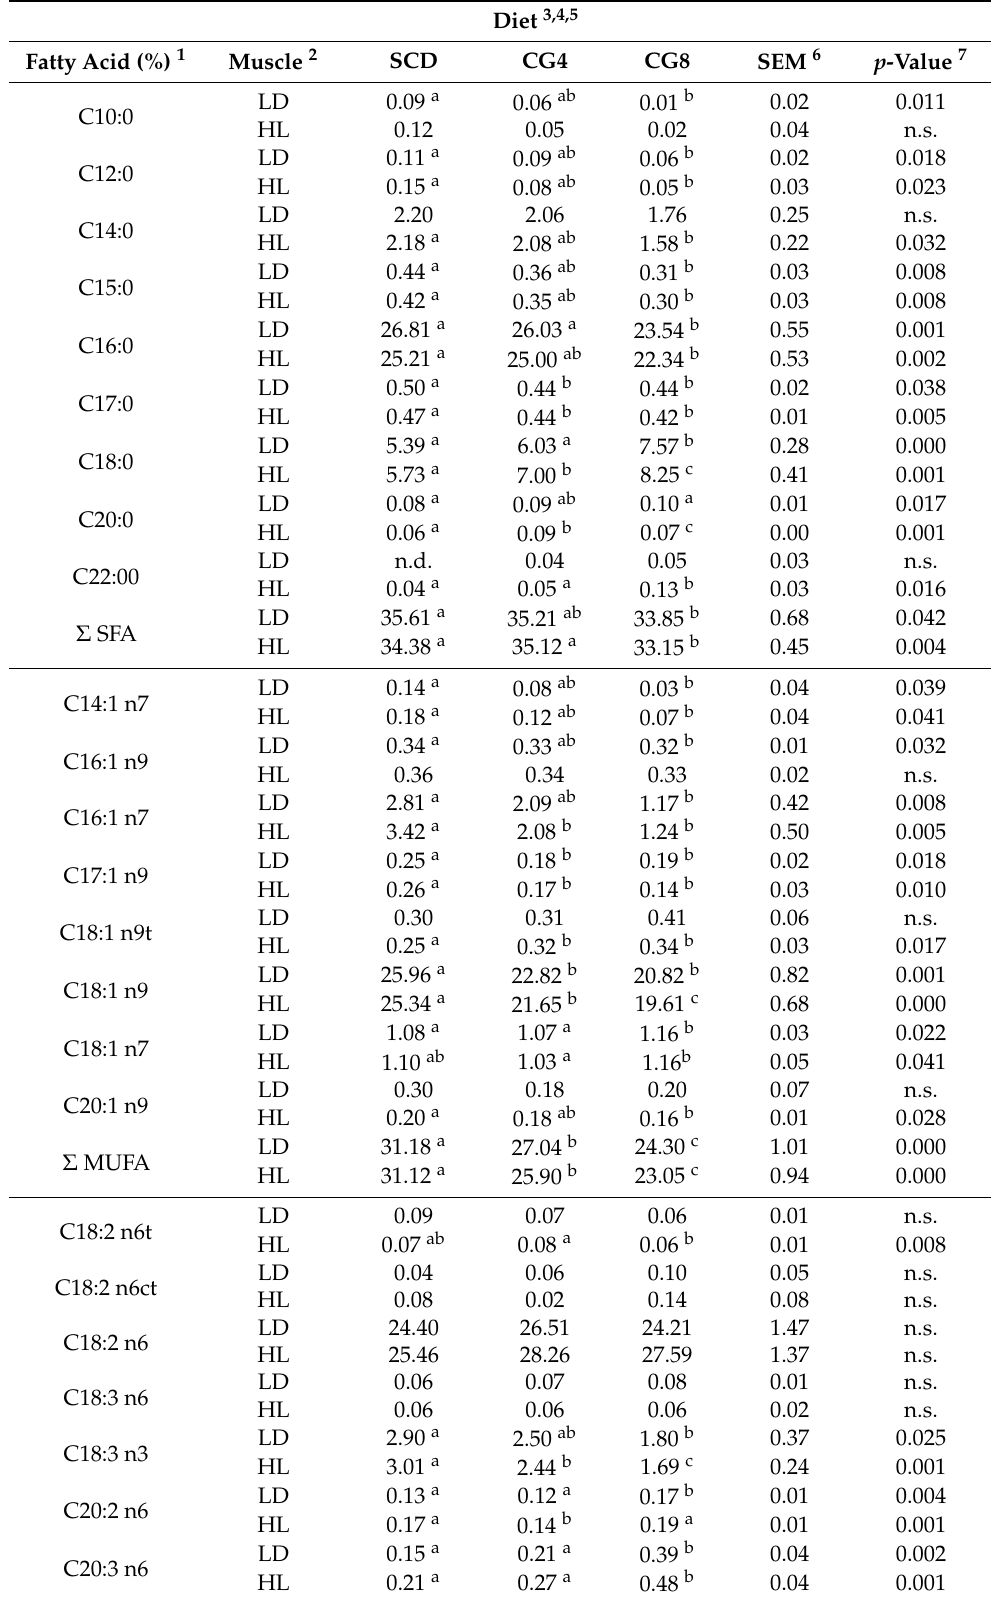
Table 5. Impact of freshwater C. glomerata biomass inclusion in the diet of rabbits on the fatty acid profile of different rabbit